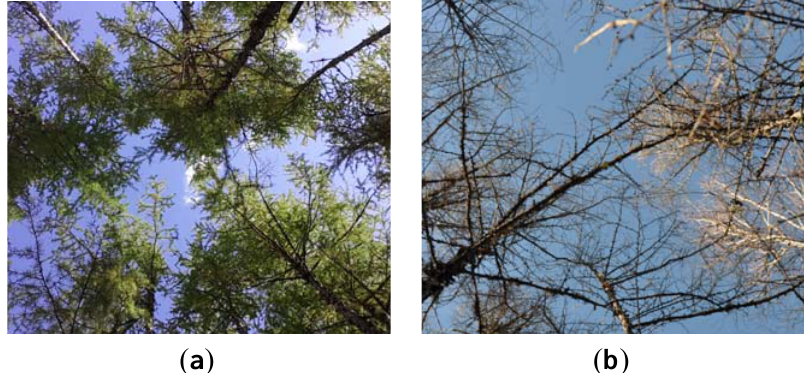
Figure 10. Photograph of coniferous forest ( a ) before and ( b ) after needle litter in the experiment site.